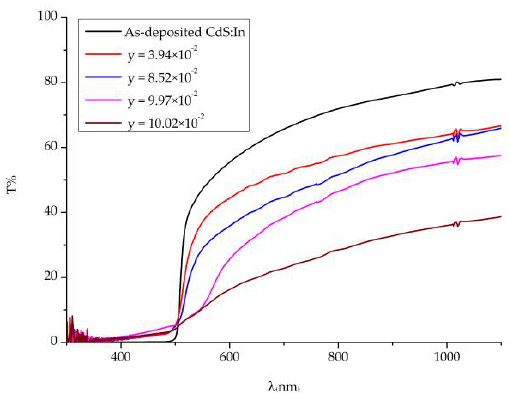
Figure 5. Transmittance of CdS 1−y Te y thin films of different composition and comparable thickness beside that of a CdS:In film.